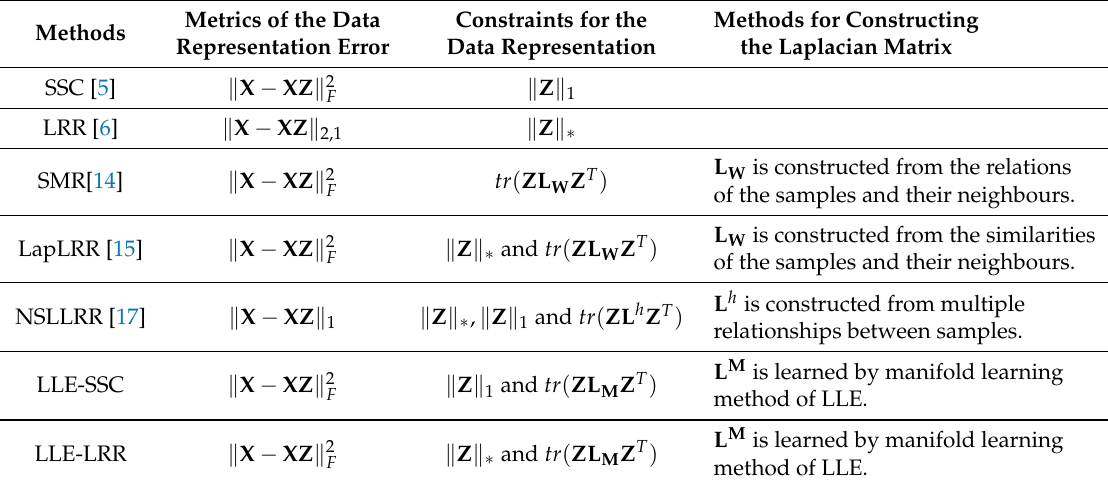
Table 1. The metrics of the data representation error, the constraints for the data representation and the methods for constructing the Laplacian matrix in the related methods and our methods. Metrics of the Data Constraints for the Methods for Constructing Methods Representation Error Data Representation the Laplacian